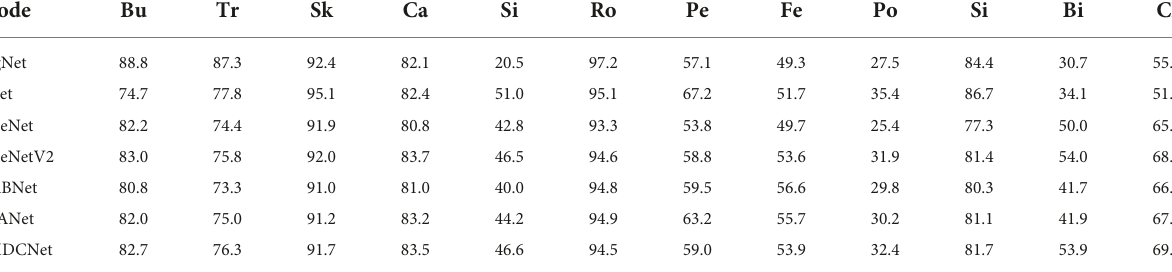
TABLE 7 Evaluation results of each class Intersection over Union (IoU) (%) and class mIoU (%) on the CamVid test set.